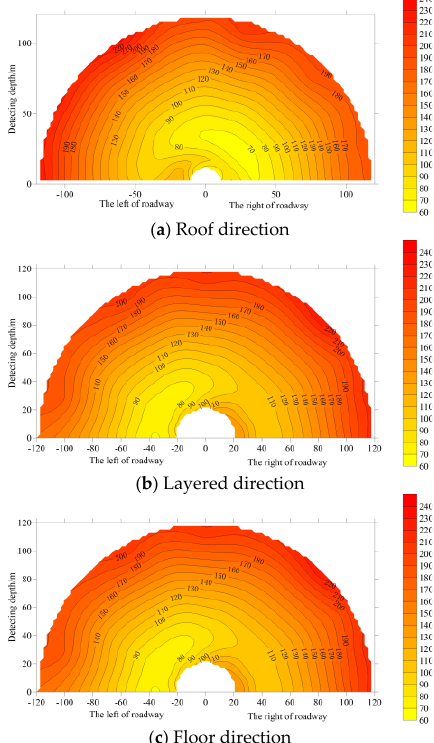
Figure 12. Detection results after grouting.